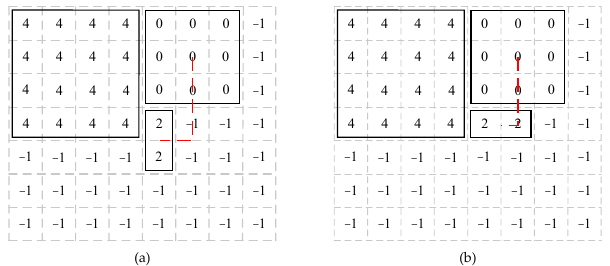
Figure 8. The distance between chiplets placed ( a ) vertically and ( b ) horizontally.